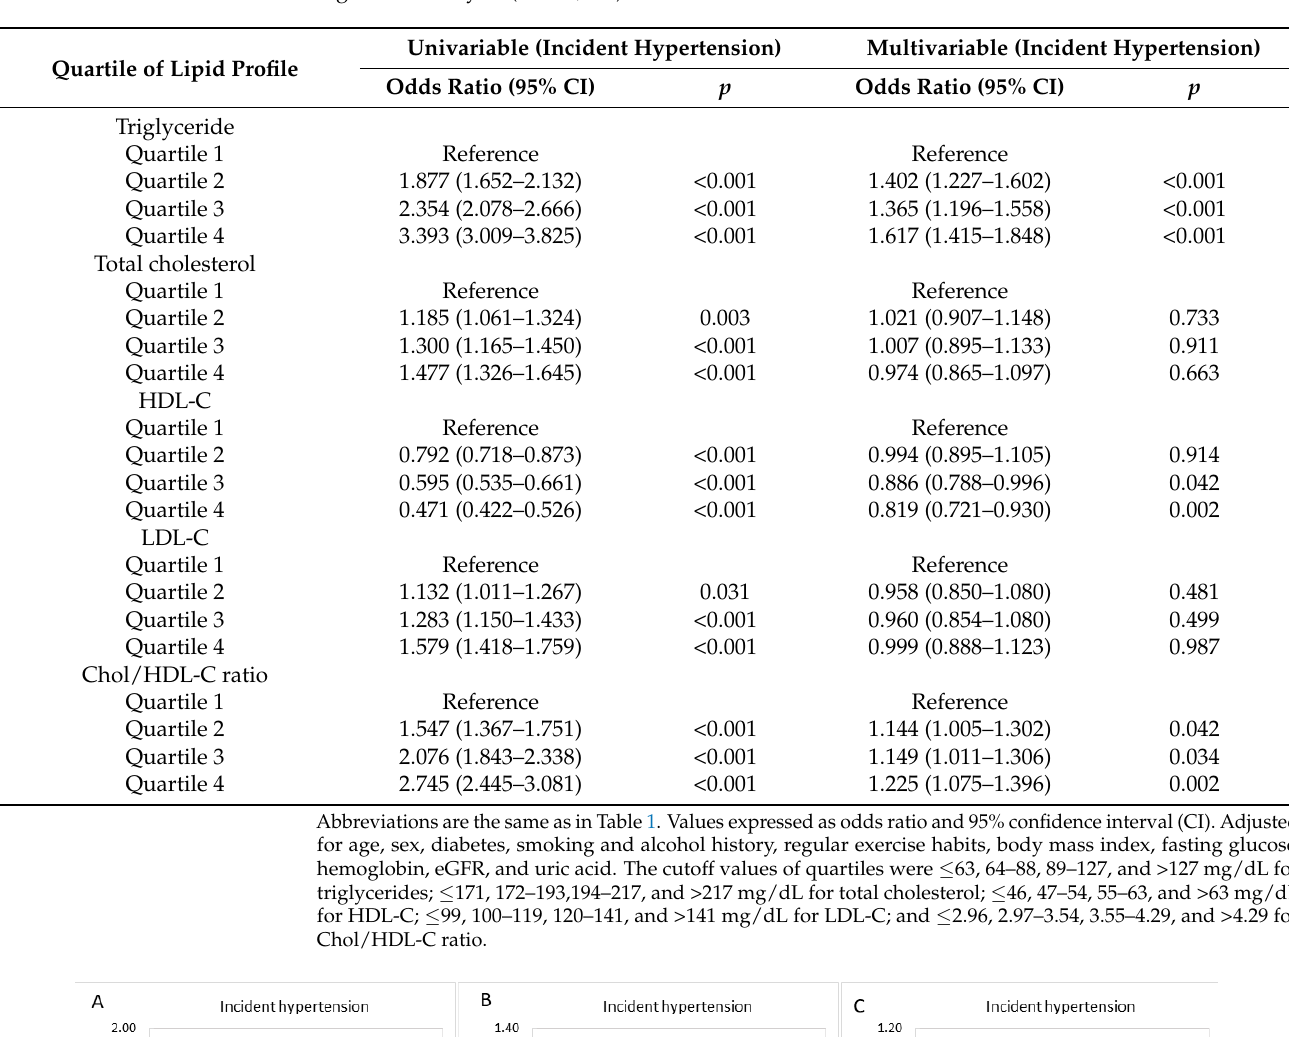
Table 4. Associations between lipid profile quartiles and incident hypertension according to logistic regression analysis ( n = 21,454).